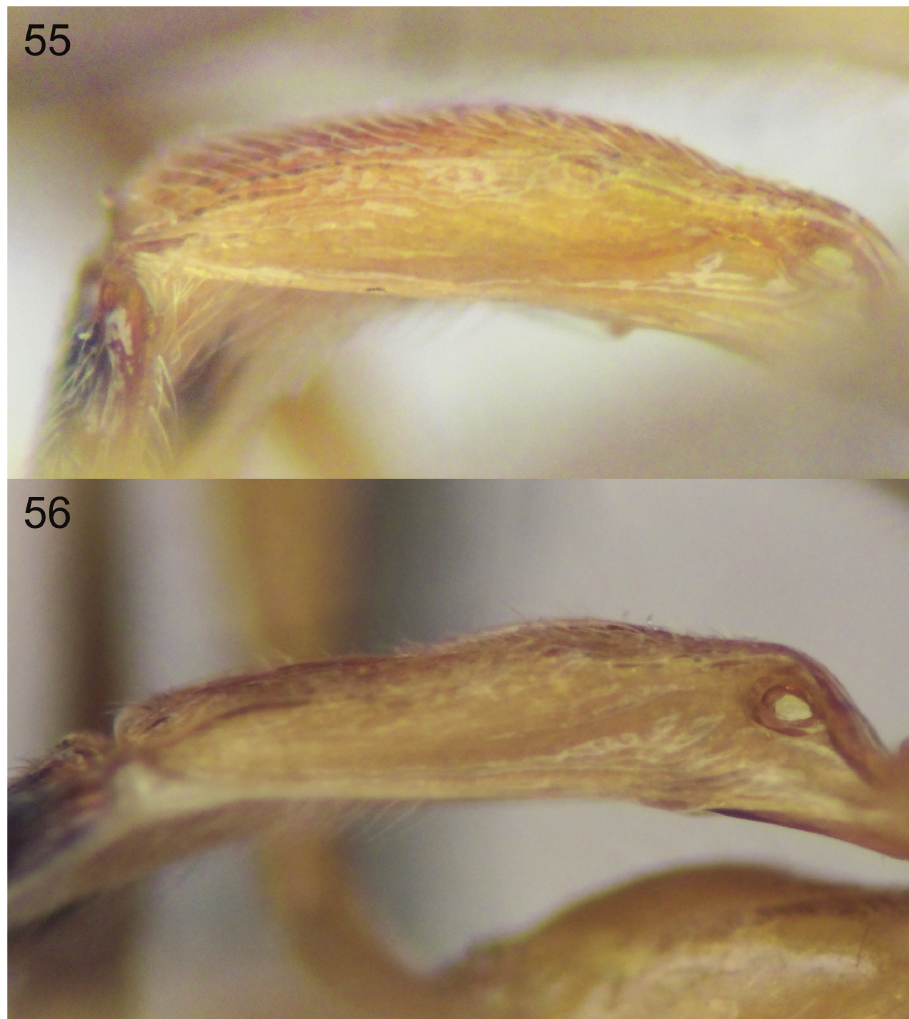
Figures 55–56. Lateral views of 1 st metasomal tergite. 55 Colastomion pukpuk sp. n. 56 Colastomion maclayi sp. Fore wing . Vein 1-CU1 postfurcal. Vein 2-CU1 8.5 × longer than 1-CU1. Lengths of veins SR1: 3-SR: r = 4.6: 3.2:1.0. Vein 2-SR 2.4 × 2-SR+M. Hind wing . Vein M+CU 2.0 × length of 1-M. Hind wing vein 2-SC+R very thick- ened, almost quadrate. Vein SR gently curving basally and gradually getting closer to anterior margin towards wing tip. Metasoma . 1 st metasomal tergite 2 × longer than posteriorly wide. 2nd metasomal tergite 1.1 × longer than maximally wide, with well developed midbasal triangular area giving rise to complete midlongitudinal carina; irregularly longitudinally striate with approximately 12 striae lateral to midlongitudinal carina. 3rd metasomal tergite